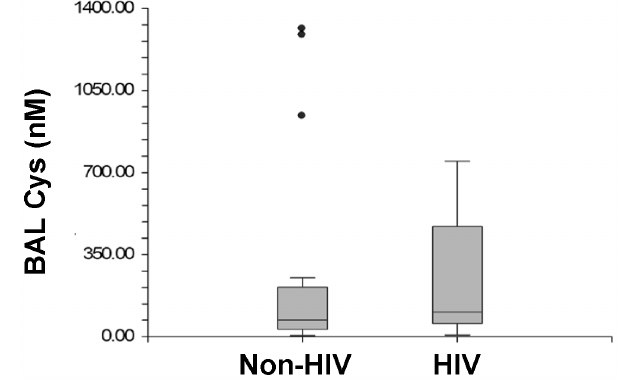
Figure 4. Box Plots of Cysteine Levels in Bronchoalveolar Lavage HIV-infected Subjects on and off Anti-retroviral Therapy.